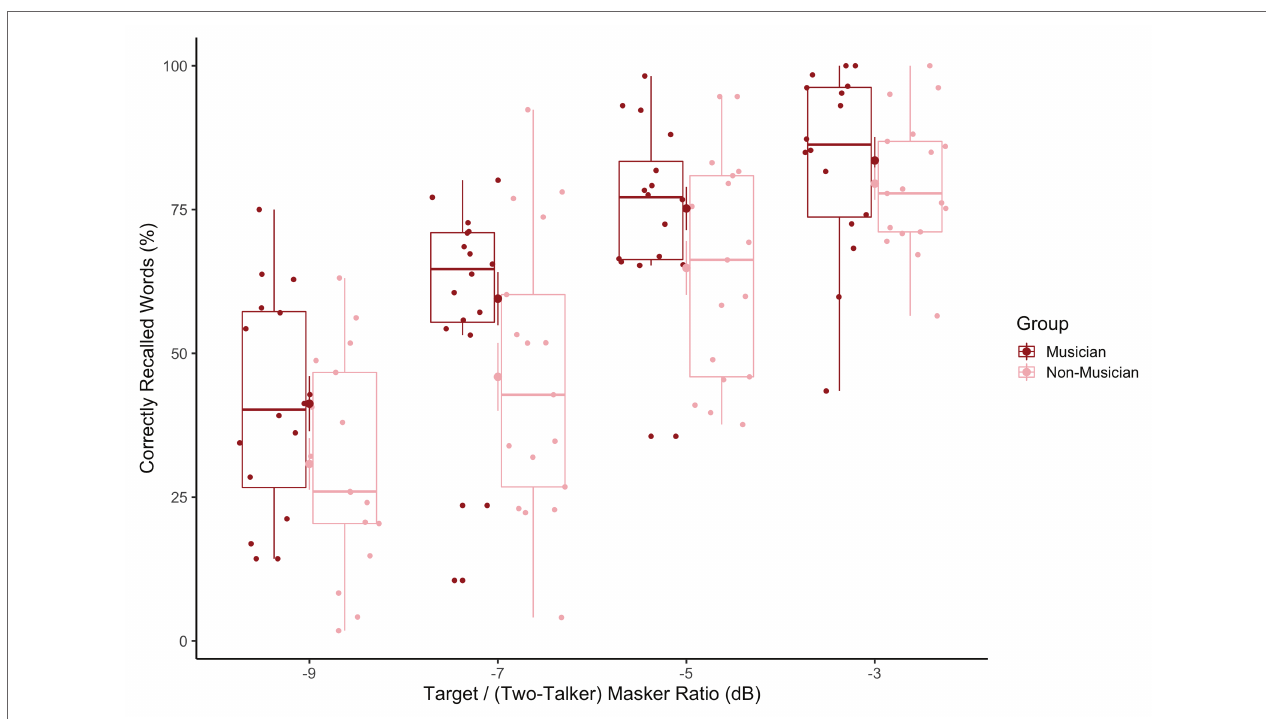
FIGURE 2 | Boxplots represent the percentage scores of correctly recalled words for musicians (dark red) and non-musicians (light pink) across Target-to-Masker Ratios (from − 9 dB most left to − 3 dB most right ). The horizontal lines in the boxes represent the median value and the dots represent data points for individual